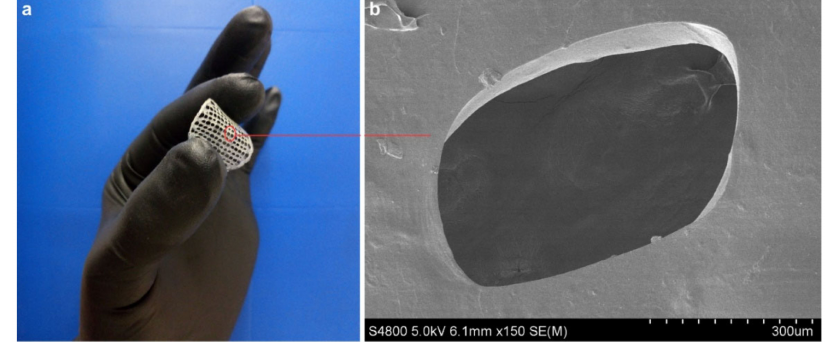
Figure 2. ( a ) A 3D printed THC6 scaffold; and ( b ) SEM image of THC6 surface.